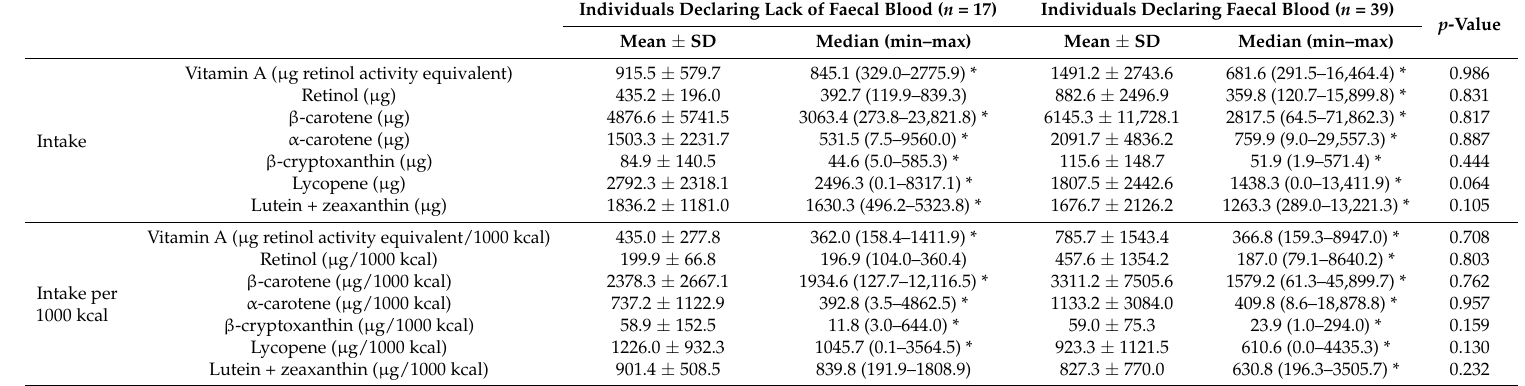
Table 2. The levels of retinoid intake in groups of individuals with ulcerative colitis declaring either a lack or presence of faecal blood (comparison conducted using U Mann-Whitney